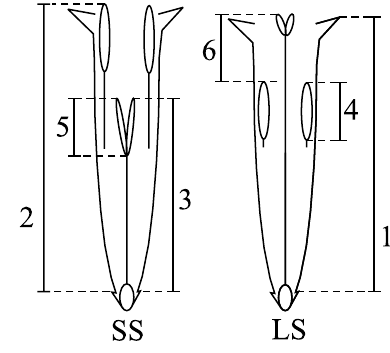
Fig. 1 – Schematic drawing of short-styled (SS) and long-styled (LS) flowers of Palicourea crocea , and measurements made from them. Numerals correspond to the following measurements for both morphs: (1) corolla length, (2) anther height, (3) stigma height,(4)antherlength,(5)stigmalobelength,and(6)difference between stigma and anther height. After Faivre and McDade